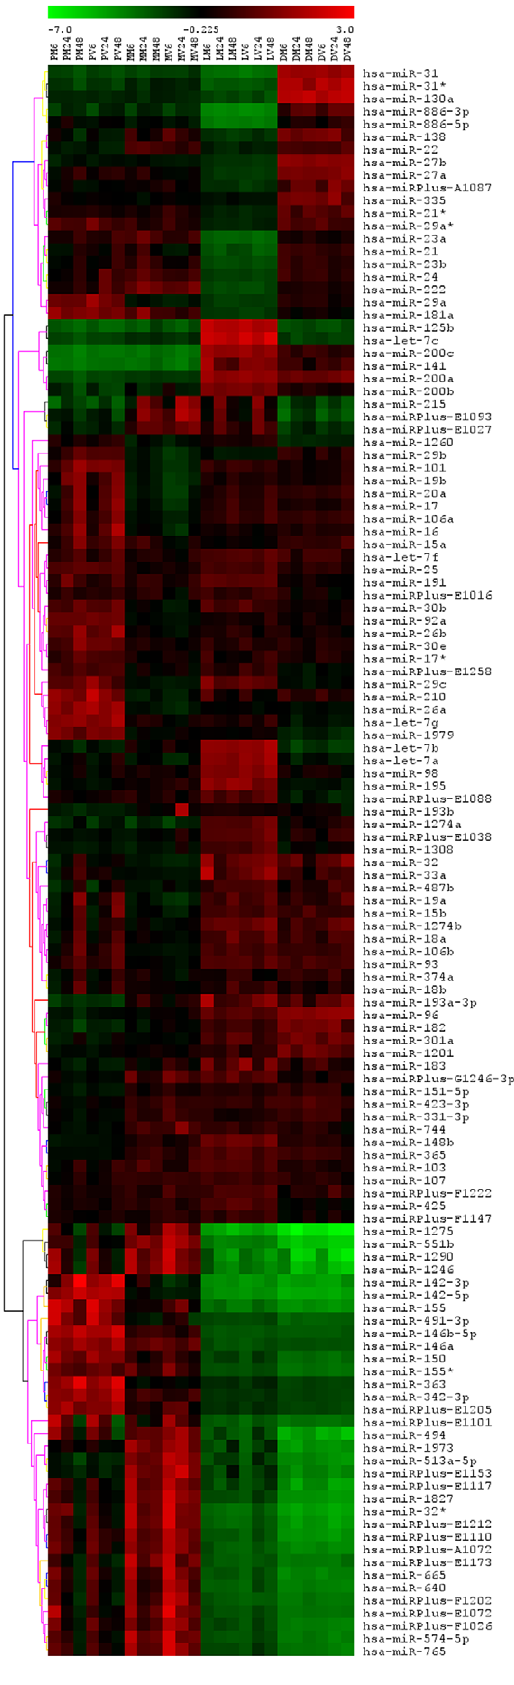
Figure 3. Heat map and unsupervised Hierarchical Clustering. The clustering is performed on all samples and on all microRNAs with standard deviation over 1. Each row represents one microRNA and each column represents one sample. The microRNA clustering tree is shown on the left. The color scale shown at the bottom illustrates the relative expression level of a microRNA across all samples: red color represents an expression level above mean, green color represents expression level lower than the mean.